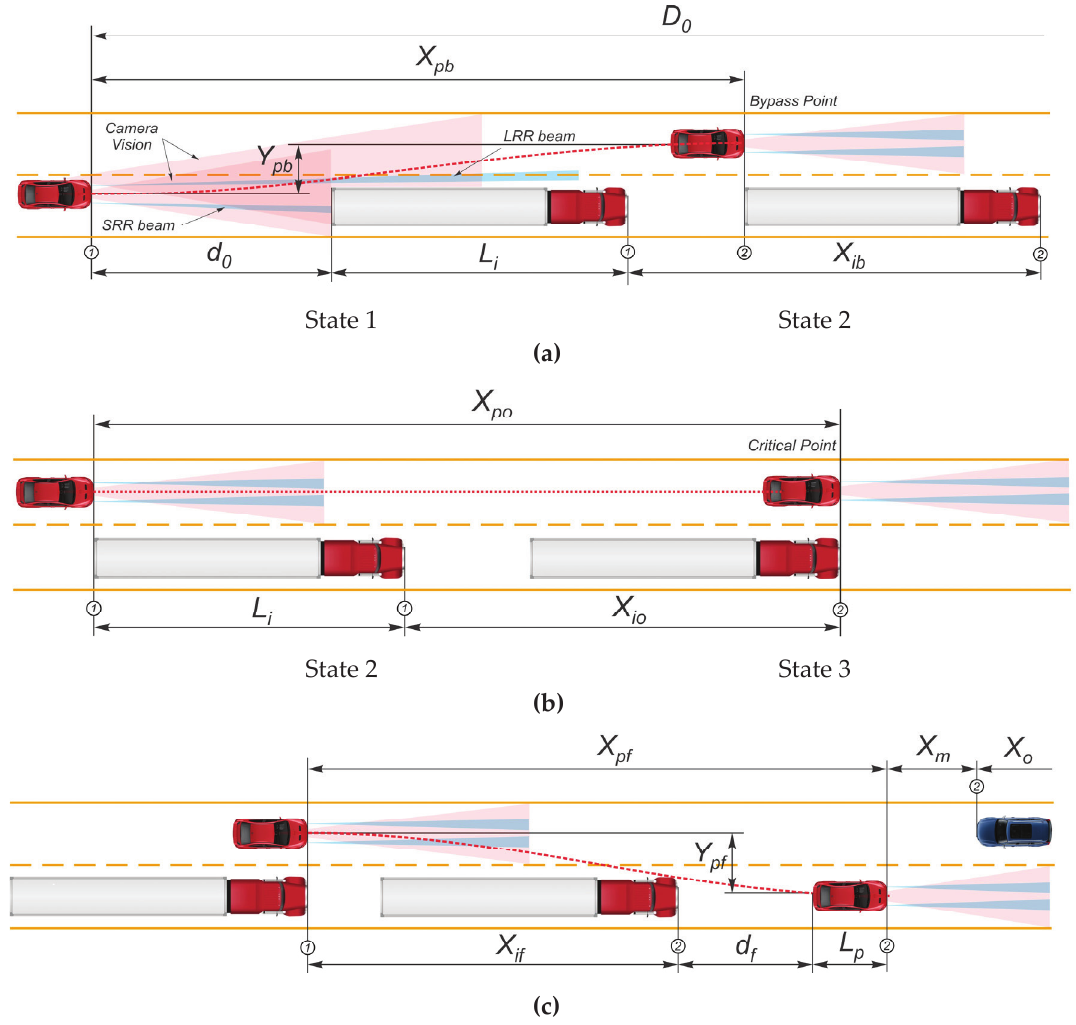
Figure 1. Phases of overtaking: ( a ) obstacle-rear reach, ( b ) obstacle-front reach, and ( c ) maneuver completion.